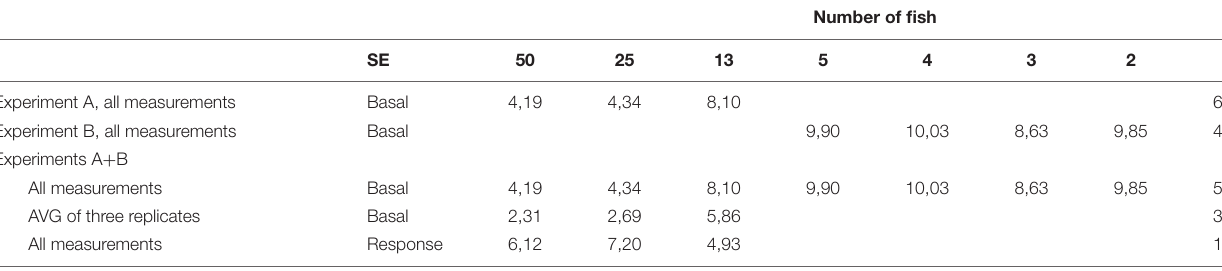
TABLE 6 | Coefficients of variation (CV) of the measured SE values for Experiments A and B.